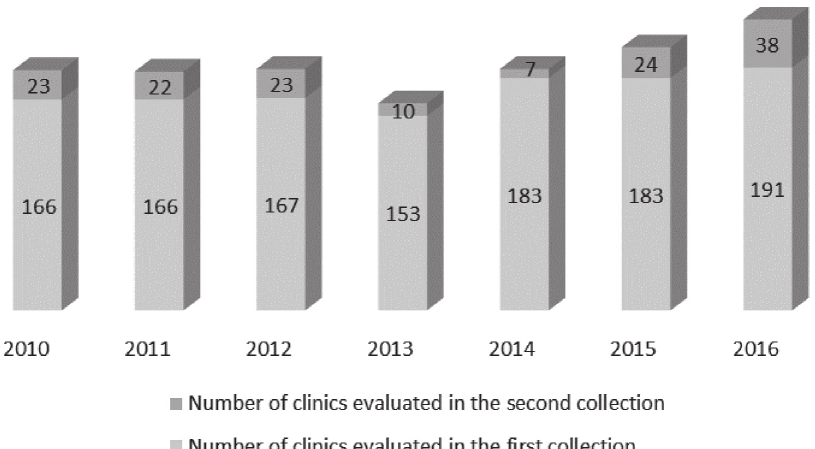
FIGURE 2 – Number of dialysis units evaluated in the first and the second water sample collection in São Paulo State, Brazil, from 2010 to